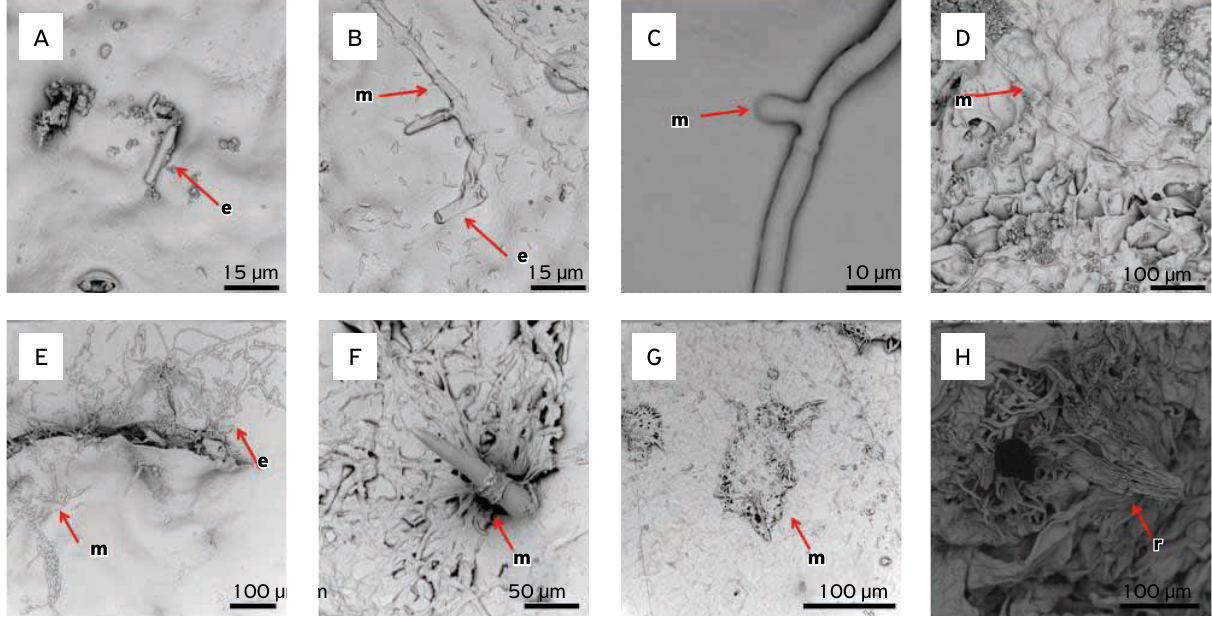
Figure 4. Isolate from passionflower at 2, 4, 6, 12, 24, 48, 72 and 96 hours (A, B, C, D, E, F, G and H, respectively) post-inoculation in